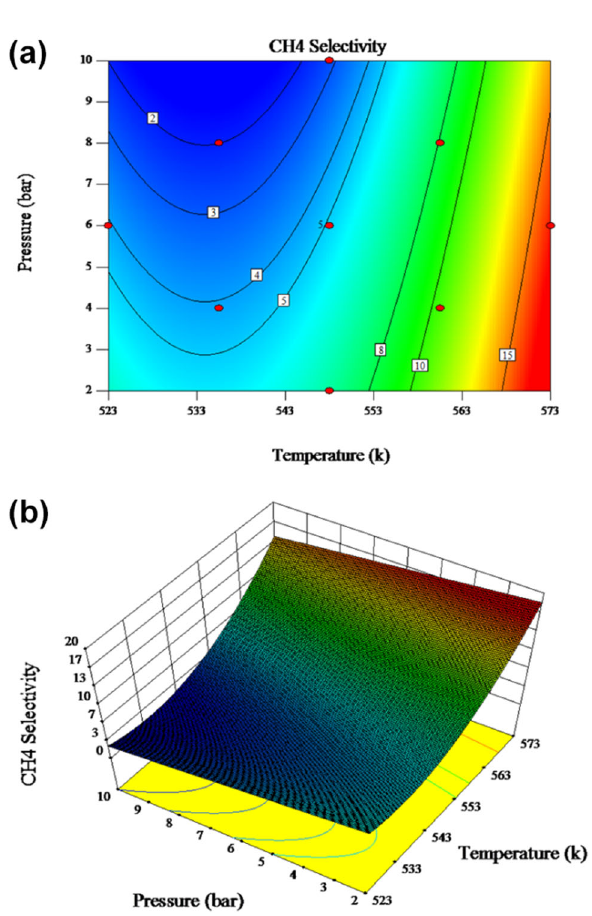
Fig. 5 Contour ( a ) and 3D surface ( b ) plots for CH 4